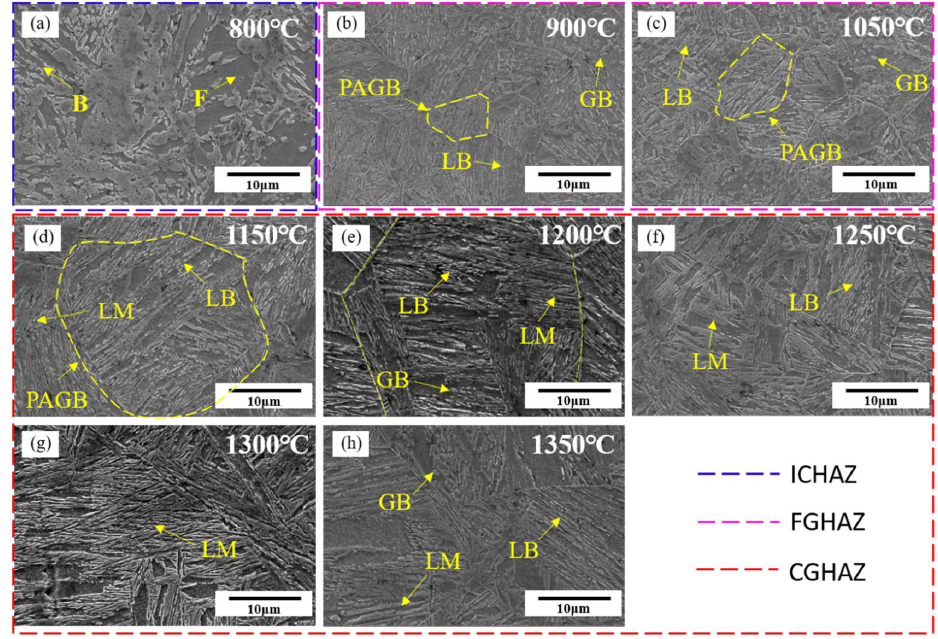
Figure 5. SEM microstructure of simulated HAZ at different peak temperatures. ( a ) 800 °C, ( b ) 900 °C, ( c ) 1050 °C, ( d ) 1150 °C, ( e ) 1200 °C, ( f ) 1250 °C, ( g ) 1300 °C, and ( h ) 1350 °C. The original austenite grain size was counted using ImageJ software. The statistical results of the original austenite grain size at different peak temperatures are shown in Figure 6. With the increase in peak temperature, the original austenite grain size increased significantly. When the peak temperature was 900 °C, the original austenite grain size was 10.13 µm. When the temperature increased to 1050 °C, the grain size of the original aus- tenite did not increase significantly. When the temperature increased to 1150 °C and 1200 °C, the grain size of the original austenite increased to about 20 µm. With the increase in the peak temperature, the original austenite grain size continued to increase. When the peak temperature was 1350 °C, the original austenite grain size reached the maximum (59.99 µm). 01020304050607080 G r a i n s i ze / 祄 Peak Temperature/? 135013001250120011501050900